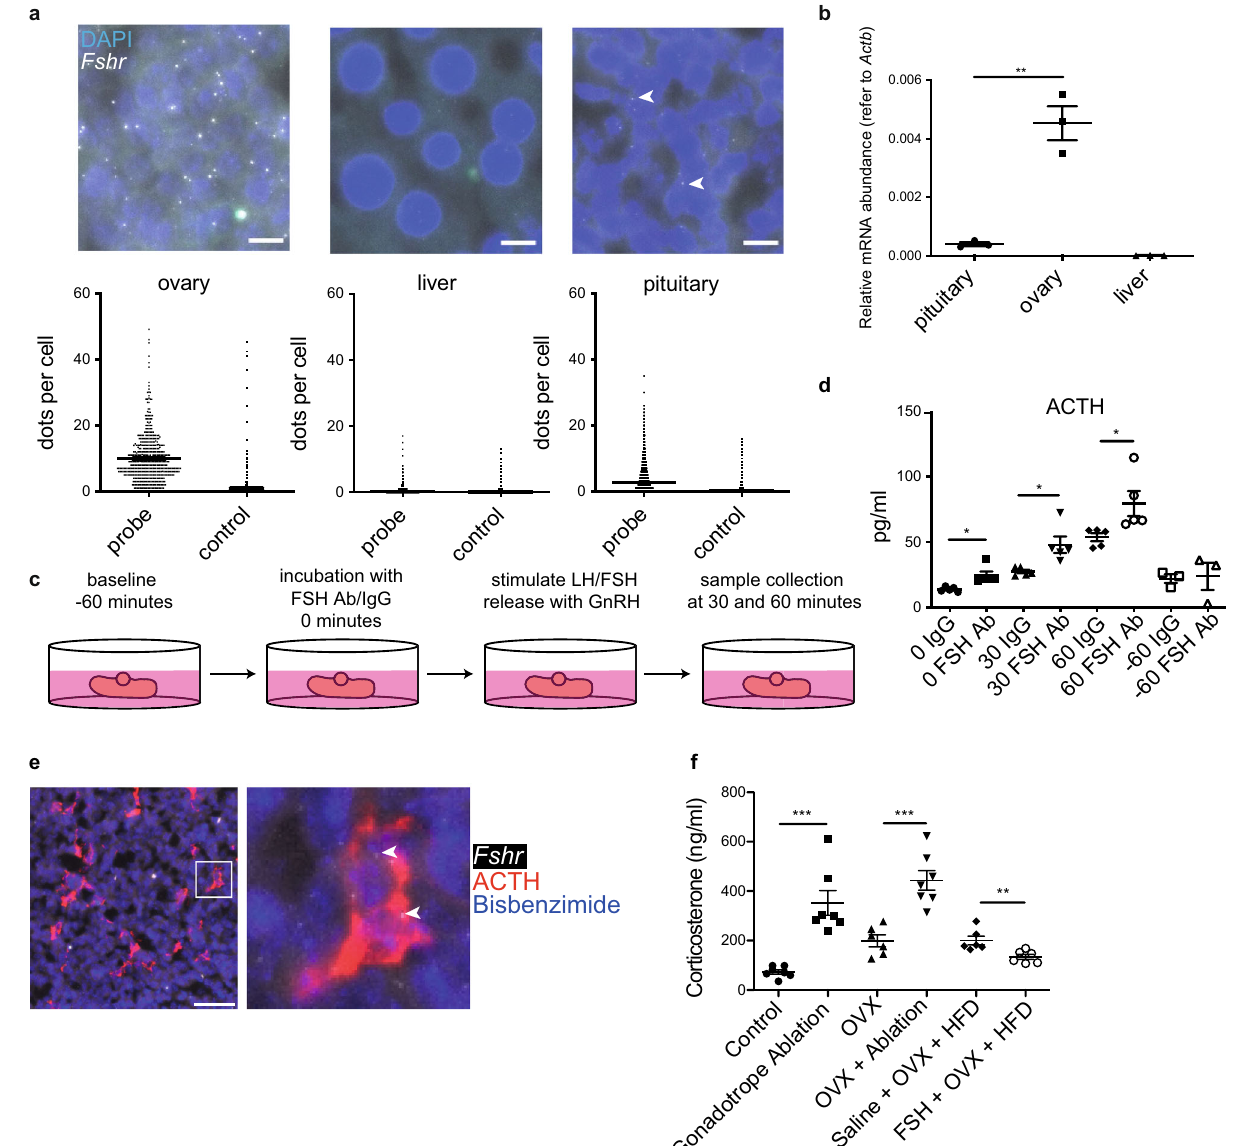
Fig. 5 | Paracrine FSH action in pituitary corticotropes in female mice. a Expression levels of Fshr in the pituitary, ovary and liver from adult female mice were measured using RNA scope (scale bars=10 μ m, fi lled arrowheads indicate positive signals) and b RT-qPCR. c Schematic representation of in vitro pituitary assay. d ACTHlevelsquanti fi edfrominvitroGnRH-stimulatedpituitariesincubated with an anti-FSH antibody or IgG (control). e Colocalization of Fshr mRNA